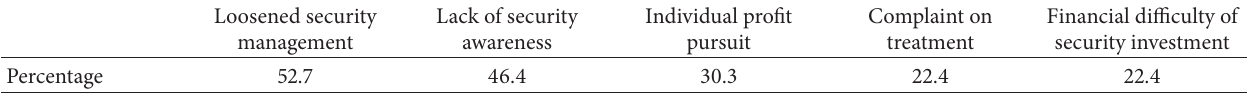
Table 5: Main causes of SMB industrial technology leakage (multiple responses, %).